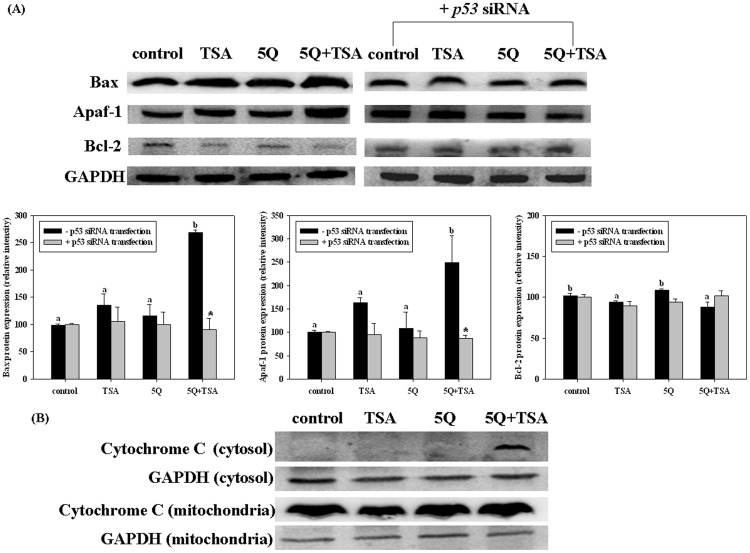
Effects of trichostatin A (TSA) alone or in combination with quercetin on Bax, Apaf-1 and Bcl-2 protein expression in A 549 cell without or with p53-silencing (A); cytochrome c levels in cytosol and mitochondria in A549 cells without p53-silencing (B).The A549 cells were transfected with or without p53 siRNA before incubation with TSA (25 ng/mL) alone or in combination with 5 µM quercetin (5Q) for 18 h. Values (means ± SD, n = 3) among the groups without p53-silencing not sharing a common letter (a-c) are significantly different (p<0.05). Values in p53-silenced cells with asterisks (*) are significantly different from in p53-normal cells with the same treatment (p<0.05).